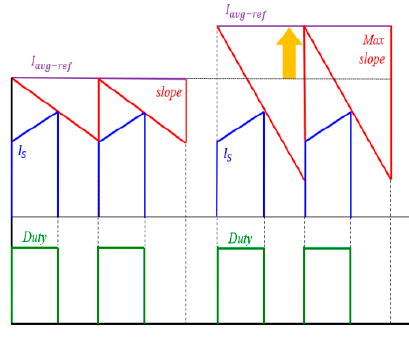
Figure 9. Inductor current waveform for changing output voltage.